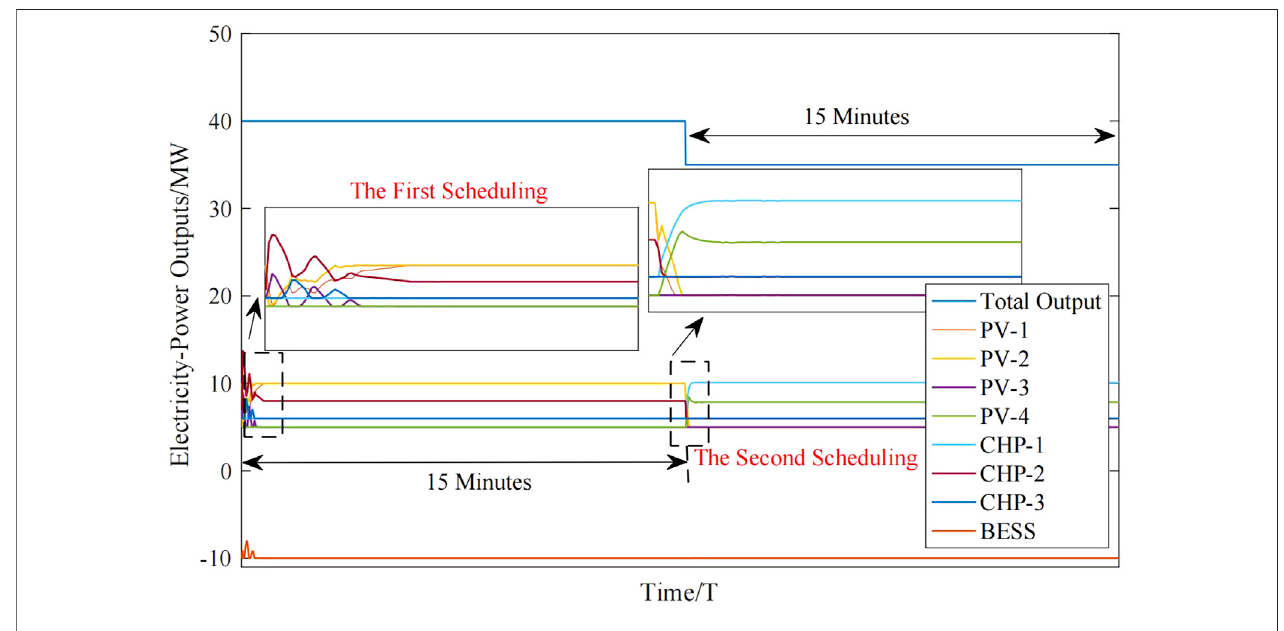
FIGURE 9 | Electricity-power outputs on generators.